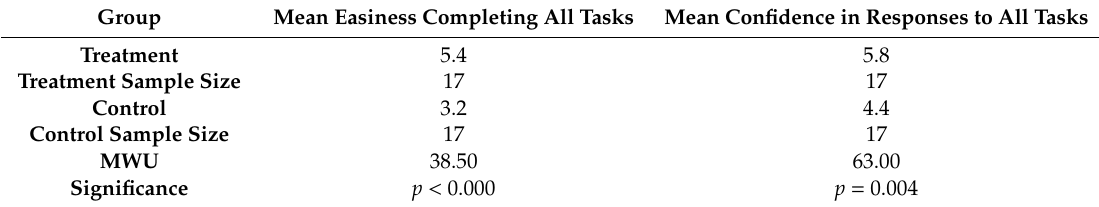
Table 6. Overall easiness of and confidence in response to